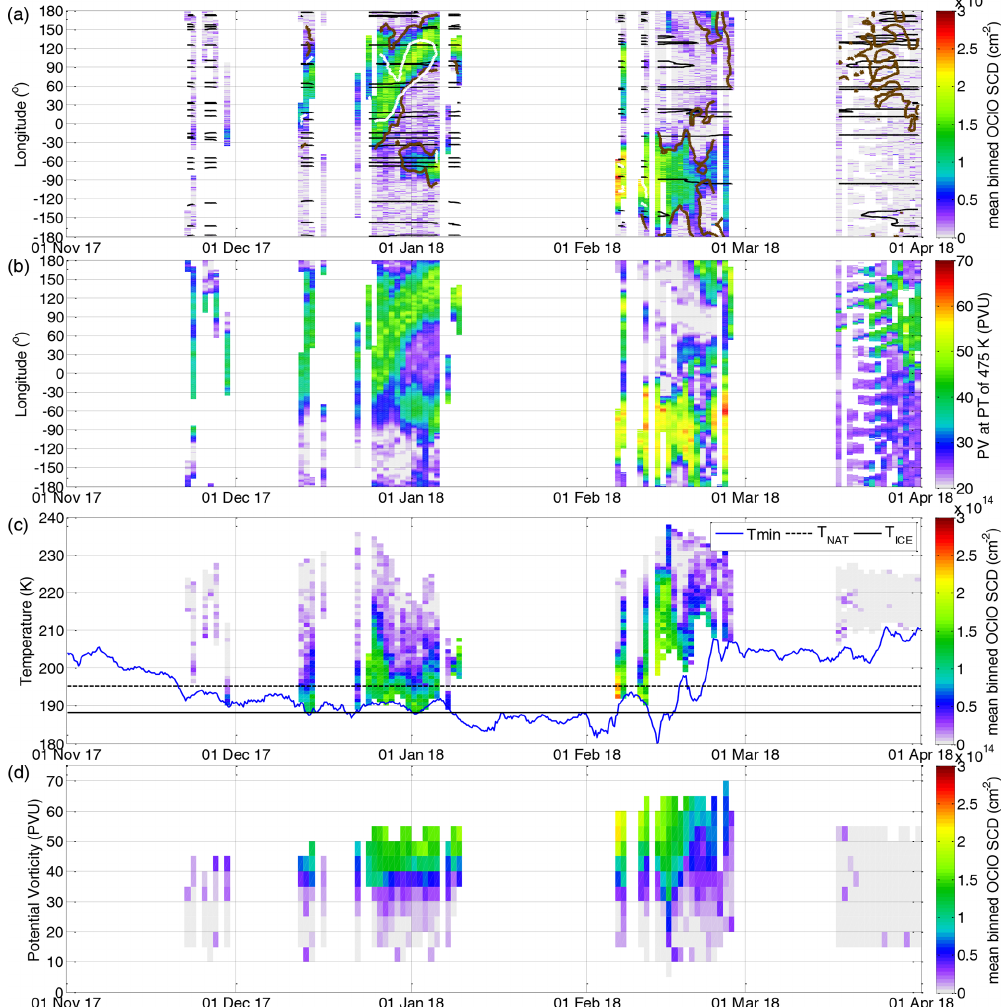
Figure 2. (a) Time series of the daily measured OClO SCDs for 89 ◦ < SZA < 90 ◦ resolved longitudinally (resolution 1 ◦ , positive values – east longitudes, negative values – west longitudes) for the Arctic winter 2017/18. Black, brown and white contour lines indicate the maximum surface elevation of 1km, PV 35PVU at PT 475K and temperature T NAT , respectively. (b) Time series of the potential vorticity at the location of the OClO measurements shown in (a) . (c) The same OClO dataset as in (a) but resolved as a function of temperature (resolution 1K) at a PT level of 475K. Here the minimum polar hemispheric temperature (minimum temperature for latitudes above 60 ◦ ) at this potential temperature level (blue line) and the values of T NAT and T ICE (at 19.5km) are also indicated. (d) Same OClO dataset as in (a) but resolved as a function of the potential vorticity (resolution